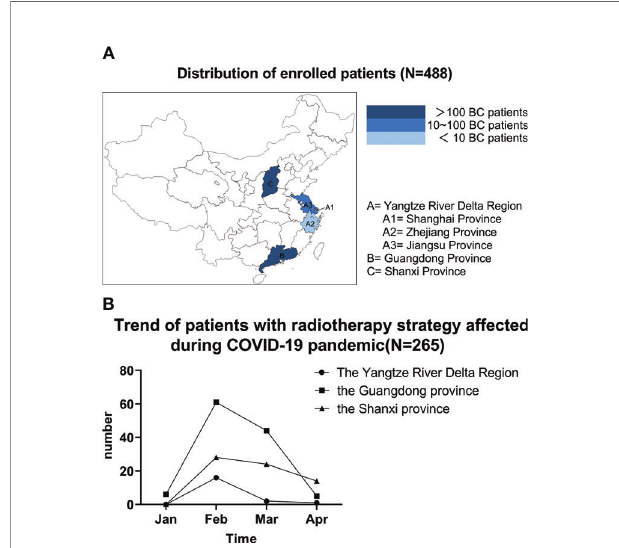
FIGURE 1 | (A) Distribution of enrolled patients (N=488). (B) Trend of patients with radiotherapy strategy affected during COVID-19 pandemic (N=265); (A) Number of patients in the Yangtze River Delta Region, Guangdong, Shanxi were 191, 193 and 104, respectively. For the Yangtze River Delta Region, most patients were from Shanghai and Jiangsu Province while only 9 patients came from Zhejiang where number of newly con fi rmed COVID-19 patients was higher than Shanghai and Jiangsu Province. (B) RT strategy were affected in late January and February in most of patients, which was peak of COVID-19 pandemic in China. BC, breast